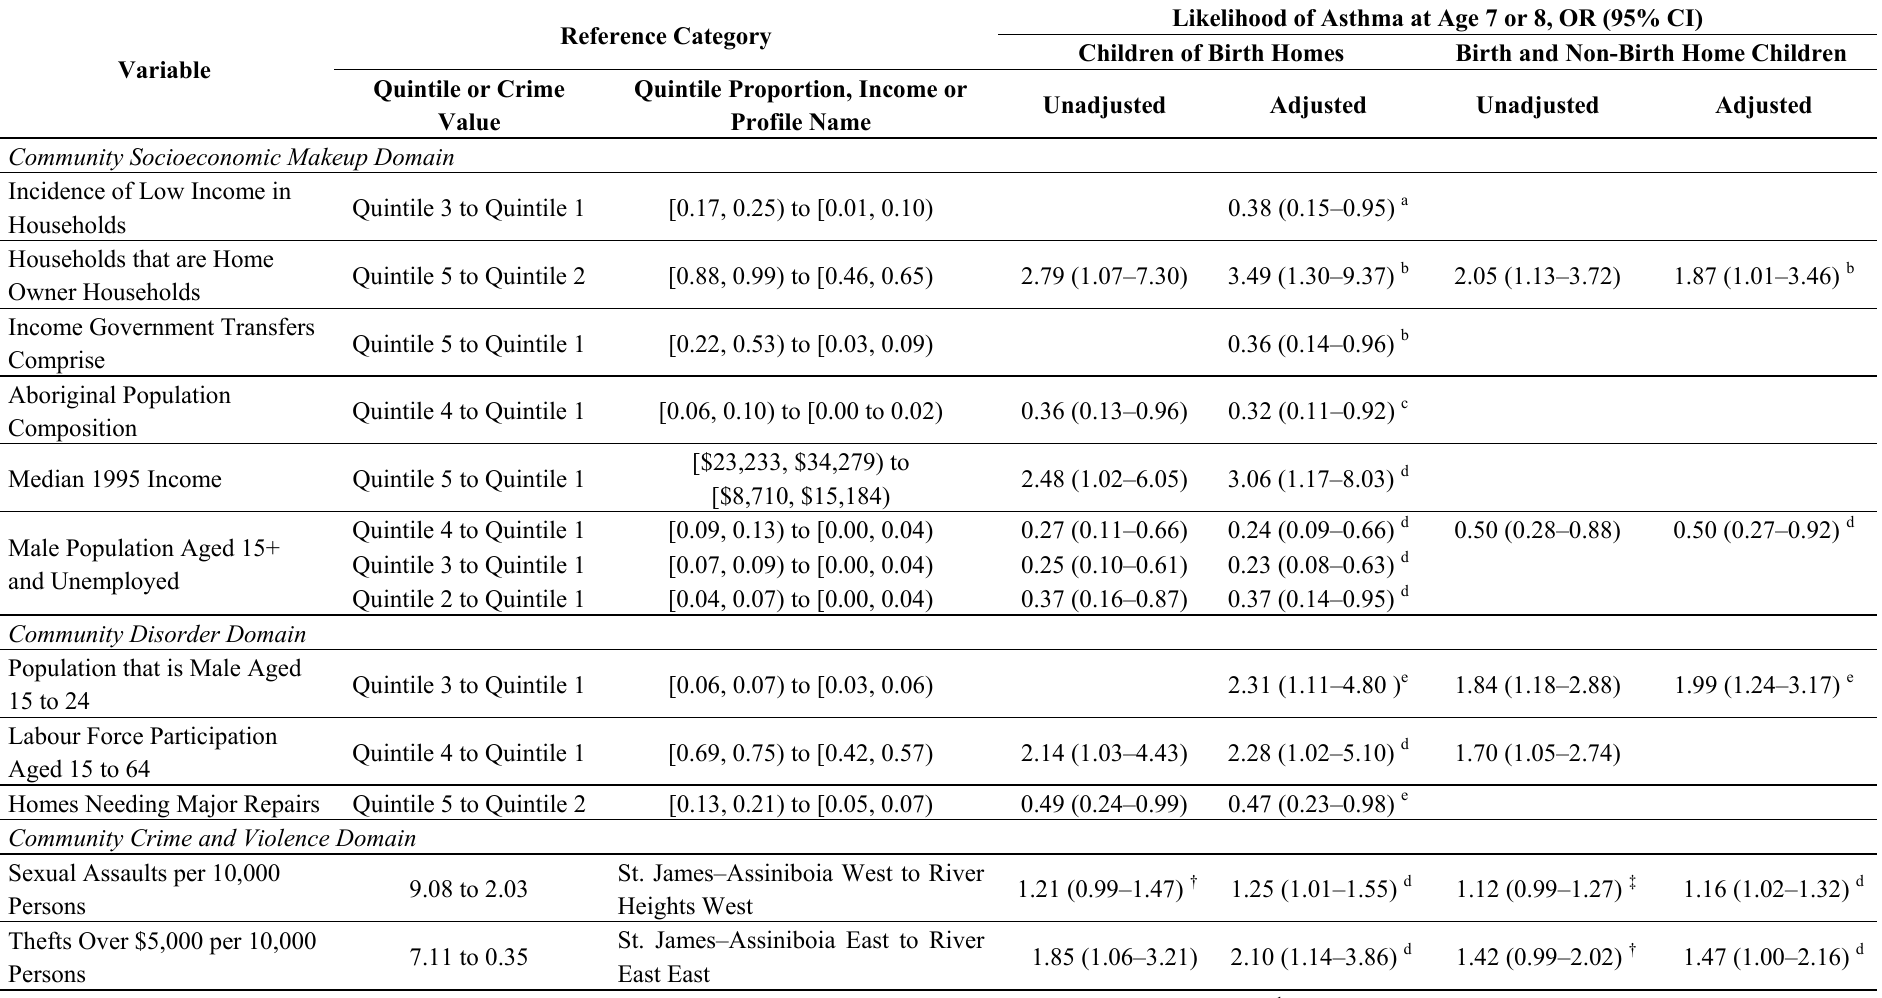
Table 2. Likelihood of Parent Reported Asthma in Winnipeg Schoolchildren According to the Presence of Community